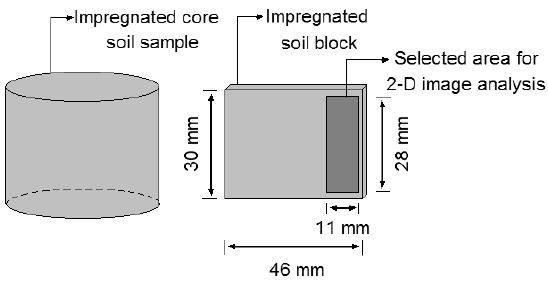
Fig. 1 – Schematic diagram of the soil block (4 . 6 × 3 . 0 cm 2 ) used for 2-D micromorphologic image